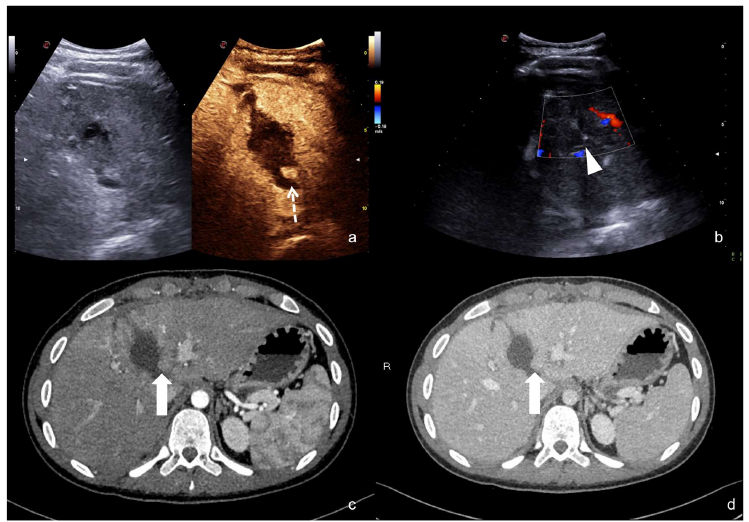
Figure 26. An example of possible pitfall at CEUS performed to follow-up a parenchymal laceration; in this case, a hepatic laceration. At CEUS examination, a nodular area of enhancement was visible within the hepatic laceration ( a , dotted arrow), suspected for PSA; however, this finding was incon- sistent with the preliminary CD–US evaluation, because the hepatic laceration area did not show any vascular pattern of PSA inside ( b , white arrowhead). This finding was suspected for pseudo- nodular spared hepatic parenchyma and confirmed at biphasic contrast-enhanced CT examination ( c , arterial phase, white arrow; d , venous phase, white arrow).